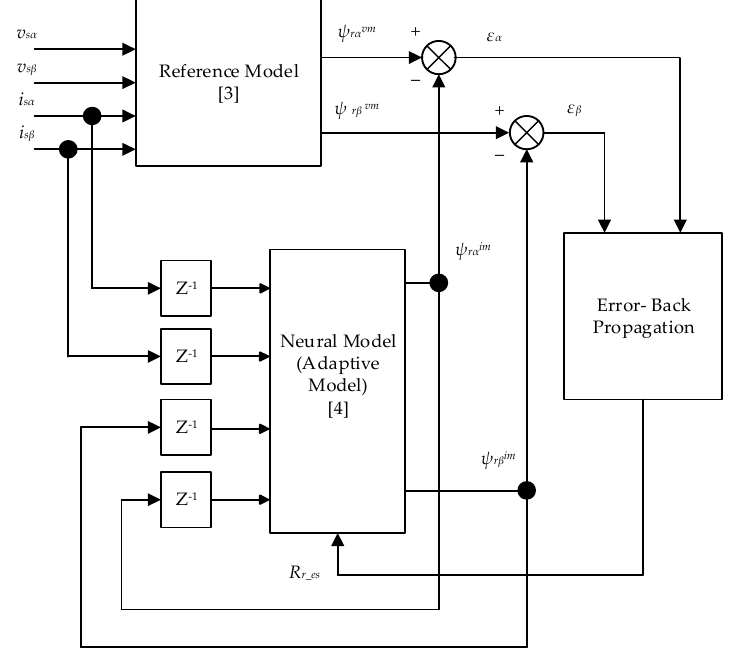
Figure 1. Rotor resistance estimator based on MRAS including a neural network trained by the error-back propagation algorithm.